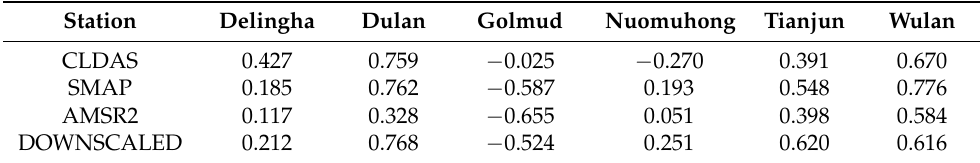
Table 6. Correlation coefficients between downscaled NN soil moisture, CLDAS soil moisture, SMAP soil moisture, AMSR2 soil moisture, and soil moisture collected from ground stations. Station Delingha Dulan